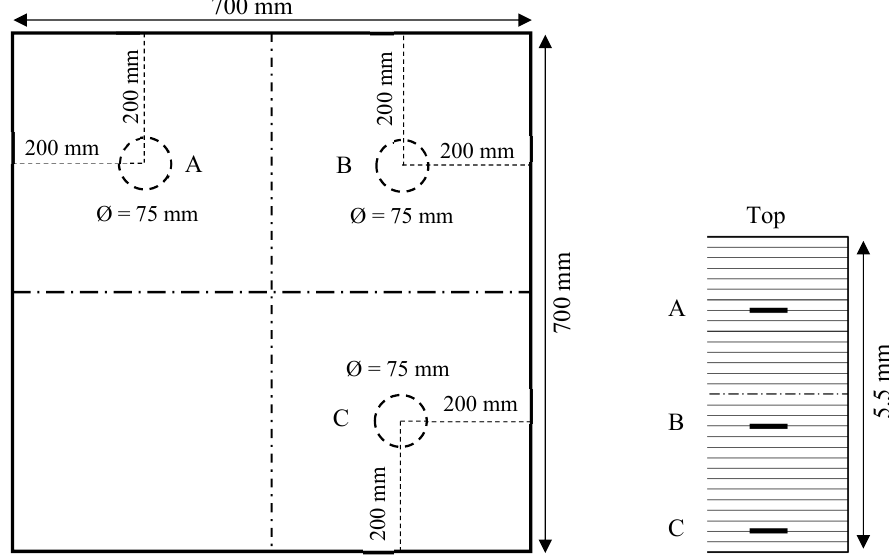
Figure 3. Schematic of the 5.5 mm unidirectional [0] 30 CFRP composite plate with three equally sized delaminations at various depths.